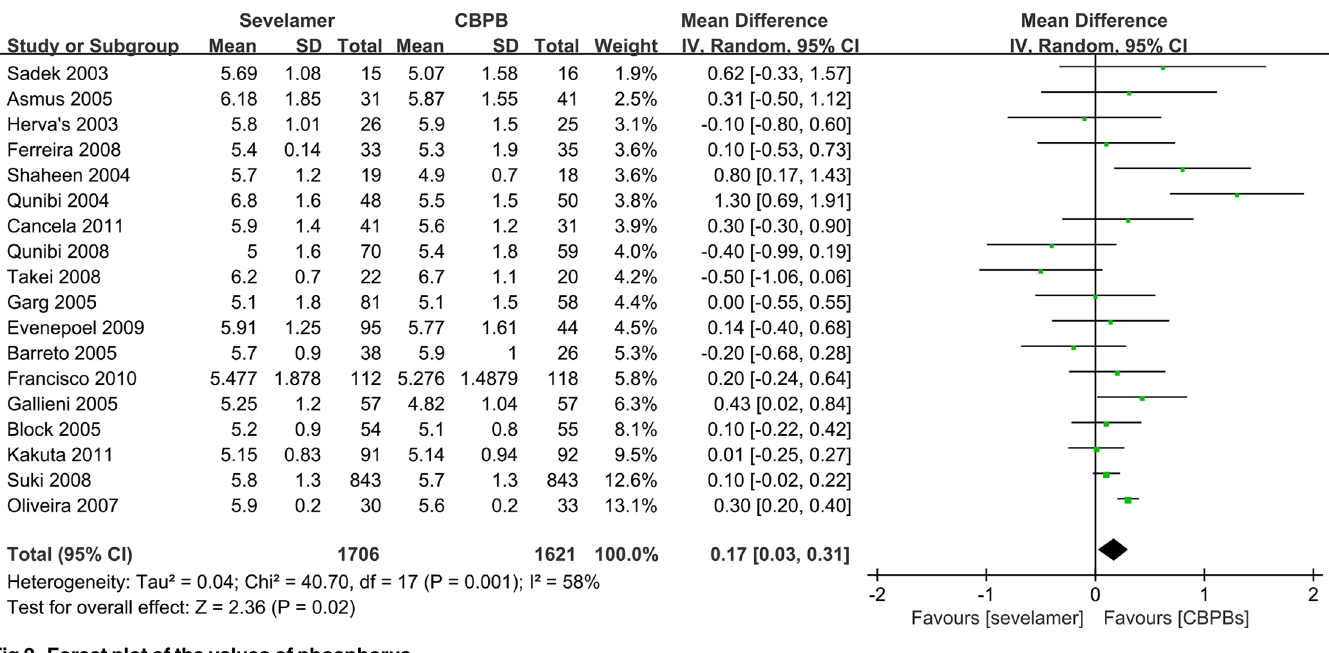
Fig 2. Forest plot of the values of phosphorus.